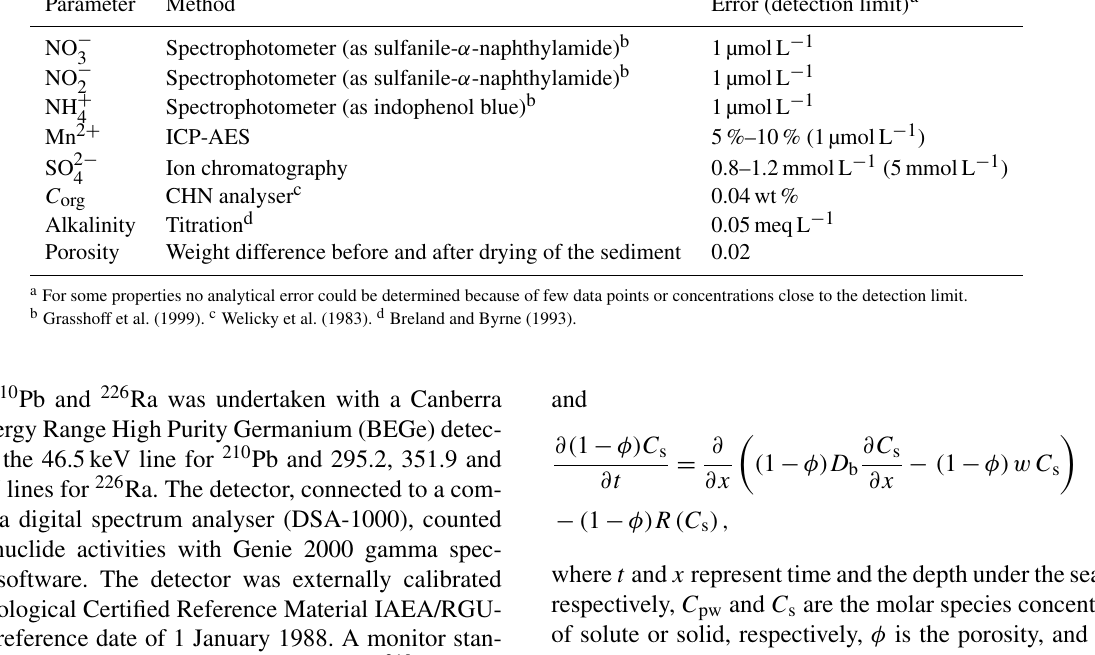
Table 2. Summary of analysed properties, analytical methods, estimated analytical errors and detection limits.